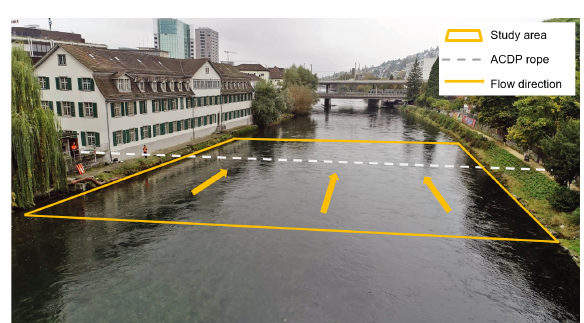
Figure 1. Limmat - Z¨urich Unterhard gauging station. A rope is suspended across the river to control monitoring